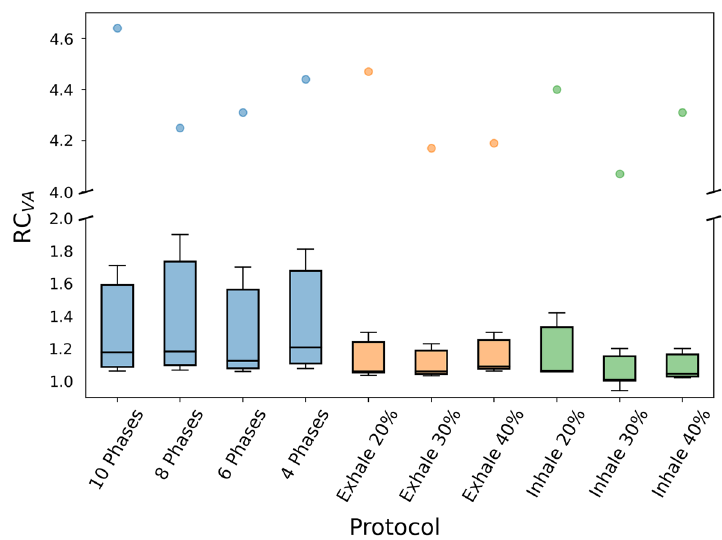
Fig. 8 Boxplots of the volume RC per protocol. Each box represents the distribution of the 50% of the data. The whiskers represent the upper and lower quartiles. The bar color scheme represents the different types of protocols. Retrospective protocols are depicted in blue, while prospective Exhale and Inhale protocols are colored orange and green, respectively